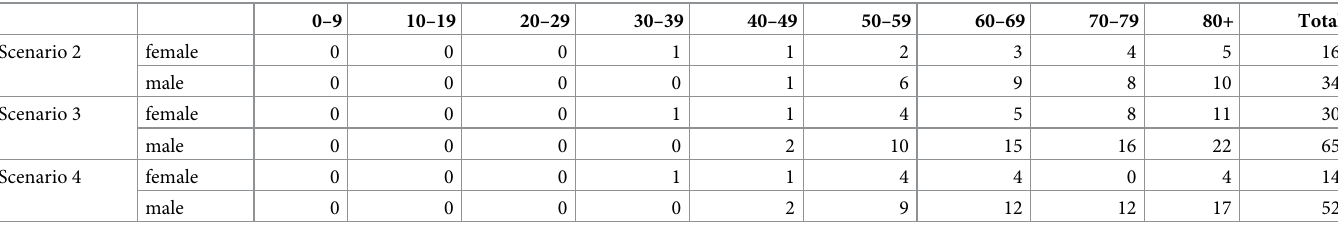
Table 4. Mean excess number of deaths.